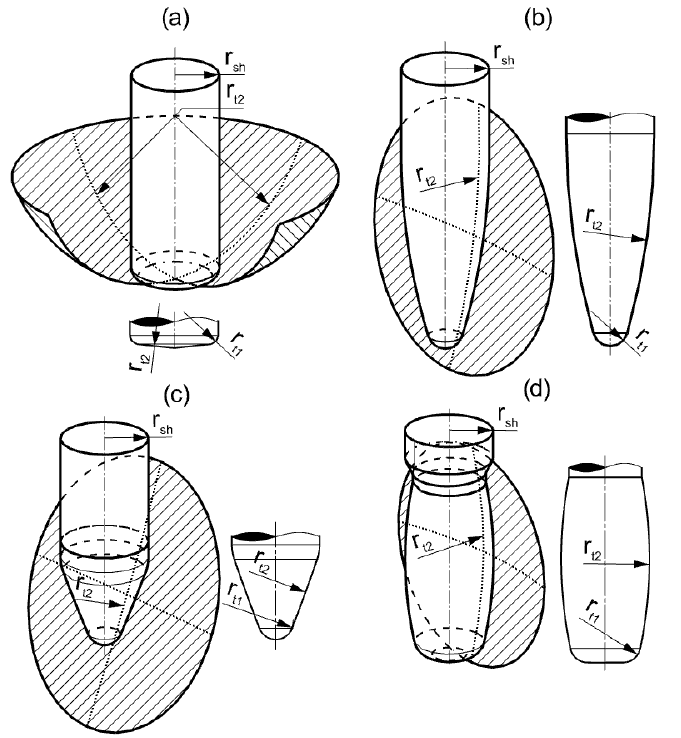
Figure 1. Circle segment end mills: ( a ) lens shape, ( b ) oval form, ( c ) taper form, and ( d ) barrel shape. The use of circular cutters allows a significant reduction in the number of machining passes while obtaining the required surface roughness after machining. The main disad- vantage of the above-mentioned tools is their limited applicability due to the shape of the workpiece (Figure 2).